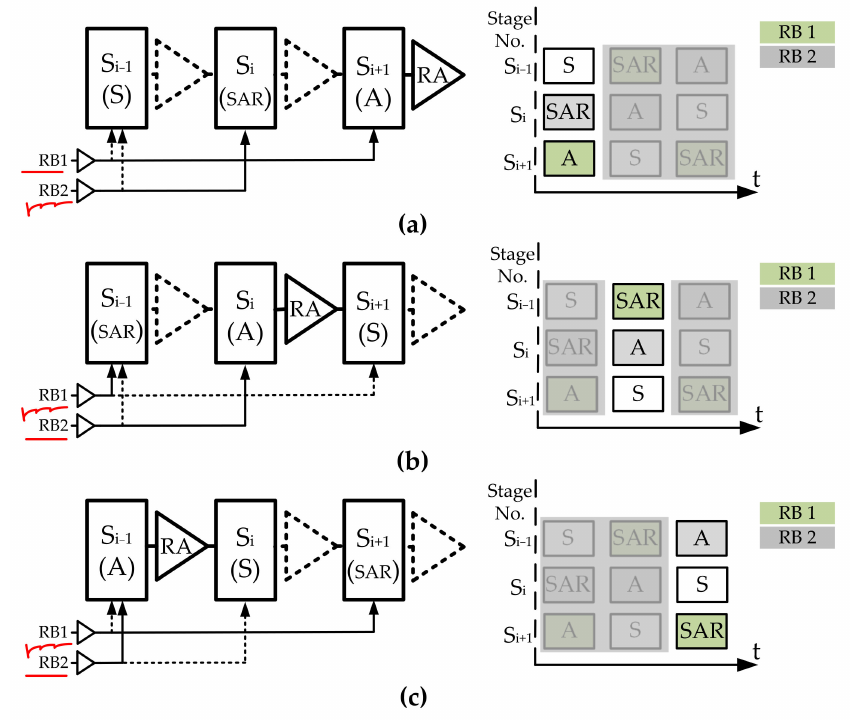
Figure 4. The phases and the connection of the reference sharing scheme along with op-amp sharing. Two reference buffers are connected to three adjacent stages ( left ). The solid and dotted lines represent the alternately connected paths. The current phase is highlighted in the timing diagram of each stage ( right ). The connected buffers are marked with green and grey. ( a ) RB1 idle, RB2 charging Si; ( b ) RB1